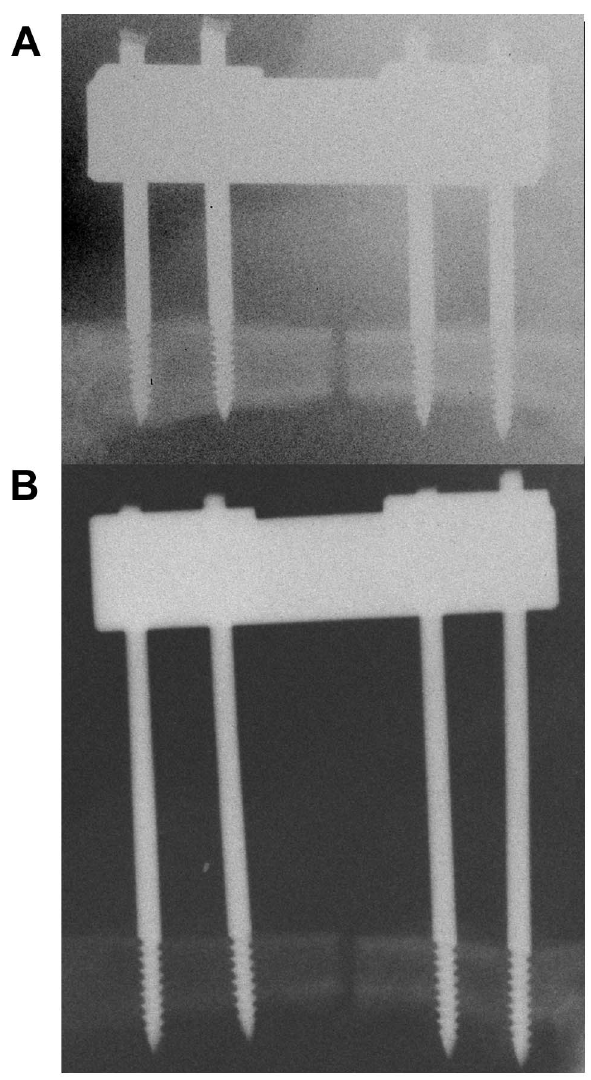
Figure 1. Radiographs of the two fixator configurations varying in the distance between bone and fixator crossbar (offset). (A) Rigid configuration with a 7.5 mm offset. (B) Semi-rigid configuration with a 15 mm offset. Osteotomy gap was set to 1.5